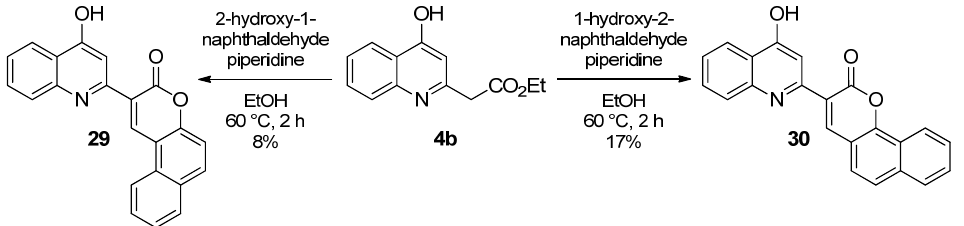
Table 2. Cytotoxic activity of the synthesised compounds on Colo 205 and Colo 320 cell lines, and normal human embryonic MRC ‐ 5